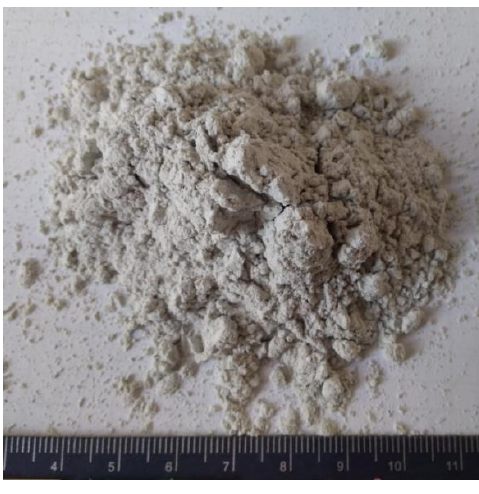
Figure 2. Glass powder. Table 2. Glass powder oxide chemical